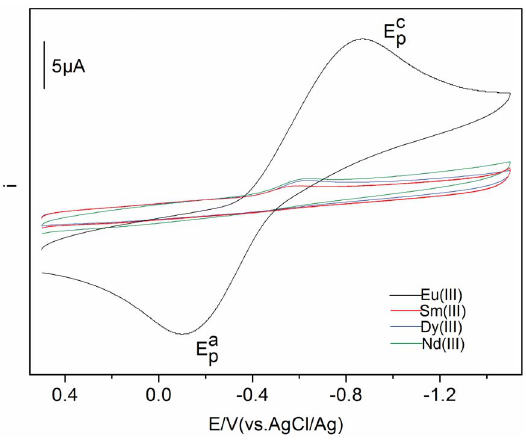
Figure 1. Cyclic voltammograms of Eu(III), Sm(III), Dy(III) and Nd(III) measured in BmimBr at 293